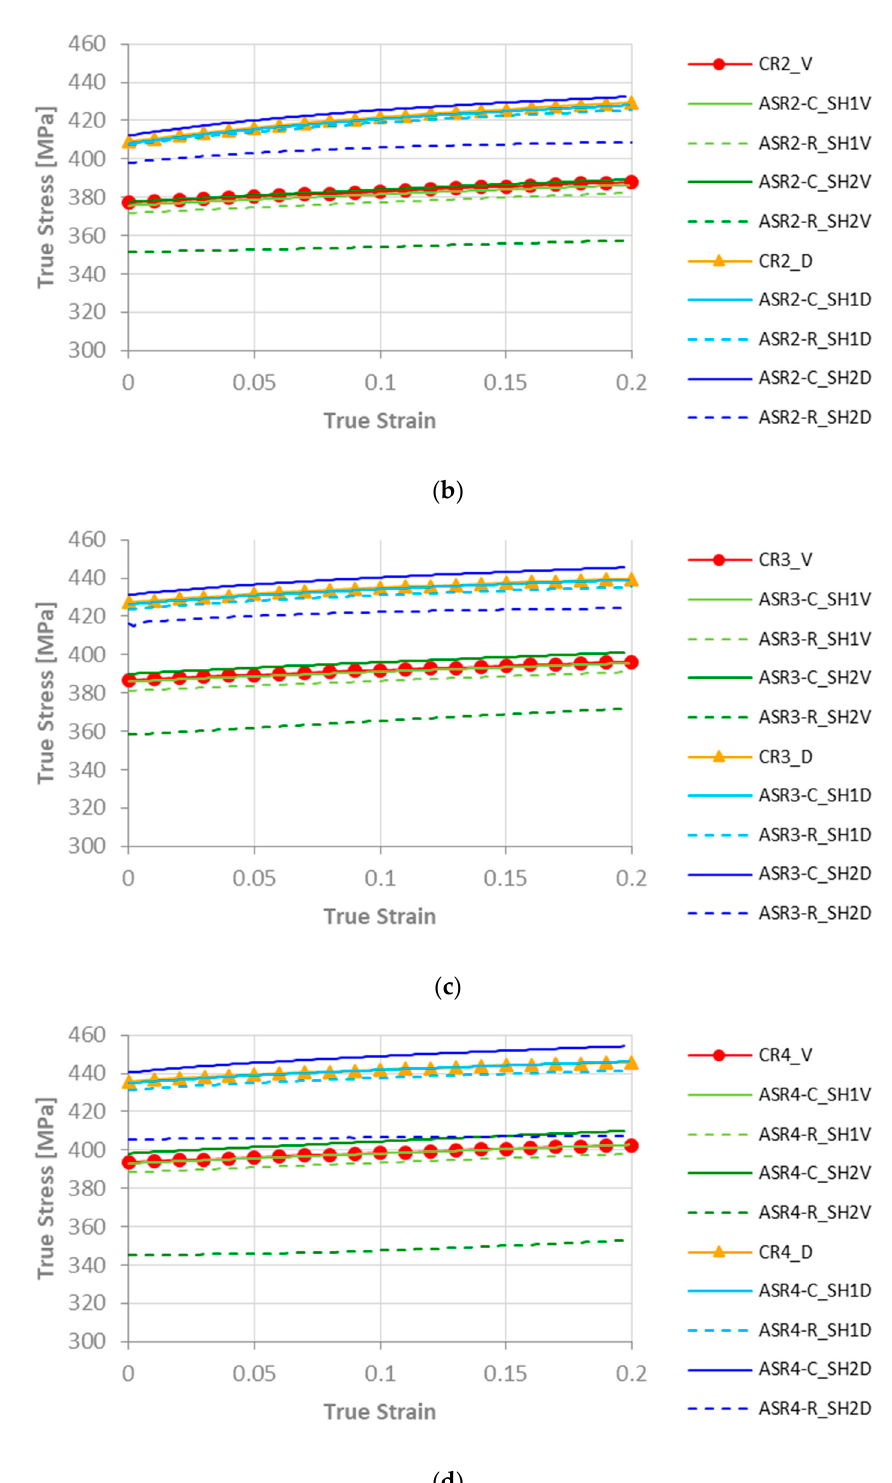
Figure 5. Stress–strain curves after a thickness reduction of 20% per pass of CR, ASR-C, and ASR-R simulations using two different hardening laws, Voce-type (V) and DDR (D), and two different amounts of shear, (SH1) and (SH2), for the asymmetric rolling tests: ( a ) 1st pass; ( b ) 2nd pass; ( c ) 3rd pass; and ( d ) 4th pass.